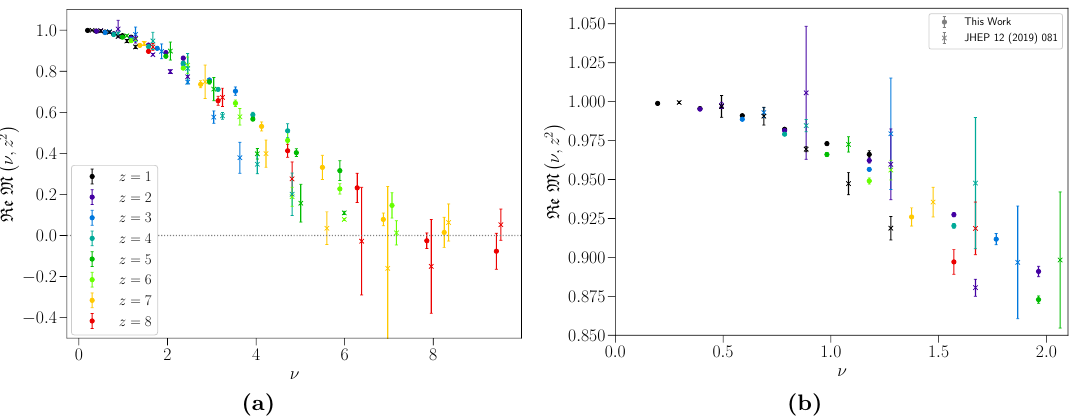
Figure 27. (a) The real component of the Ioffe-time pseudo-distribution computed in this work (circles) compared with the results of ref. [58] using Jacobi smearing (crosses). (b) Focusing on the small- ν region, the improvements afforded by distillation are seen to be considerable. Data from ref. [58] has been shifted horizontally for legibility.